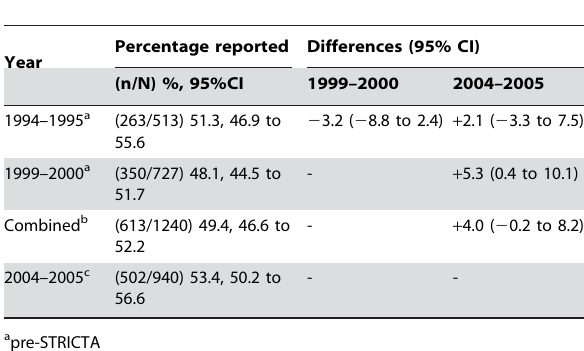
Table 2. Percentage of STRICTA items reported and between time-period